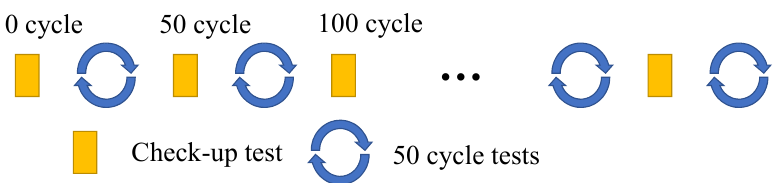
Figure 1. Schematic diagram for testing battery SOH in the battery aging